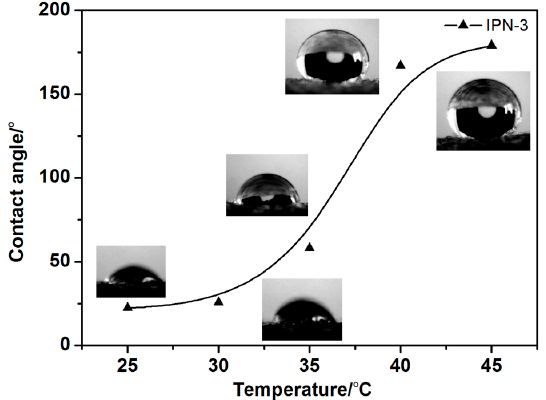
Figure 9. Contact angle measurements of the IPN hydrogel (IPN-3)-modified cotton fabric at different temperatures.